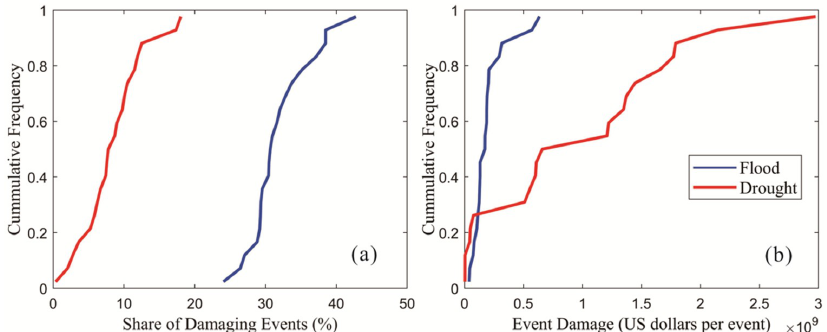
Figure 2. Comparison of the cumulative distribution functions of ( a ) share of damaging events (SDE) and ( b ) event damage (DPE) for floods and droughts for the period 1996–2016.